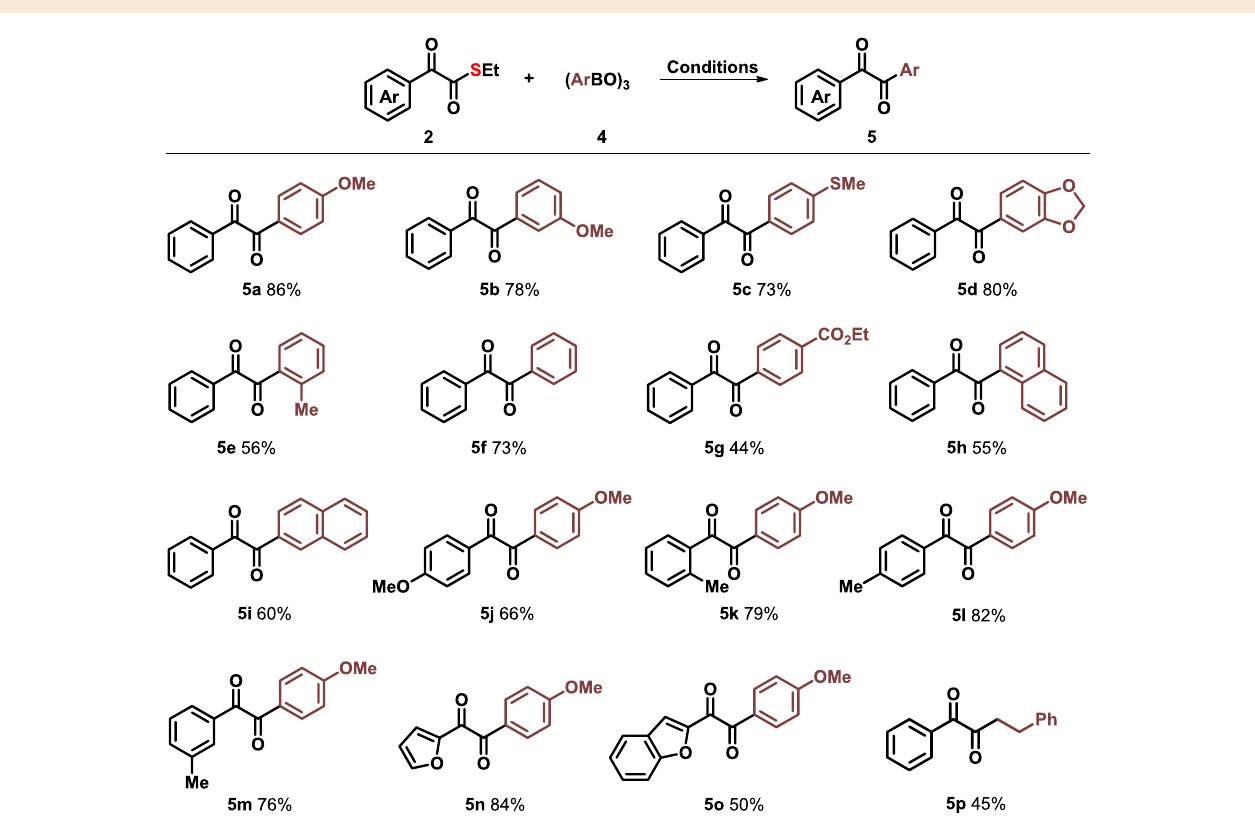
Table 4 Dicarbonylation of aryl borates a